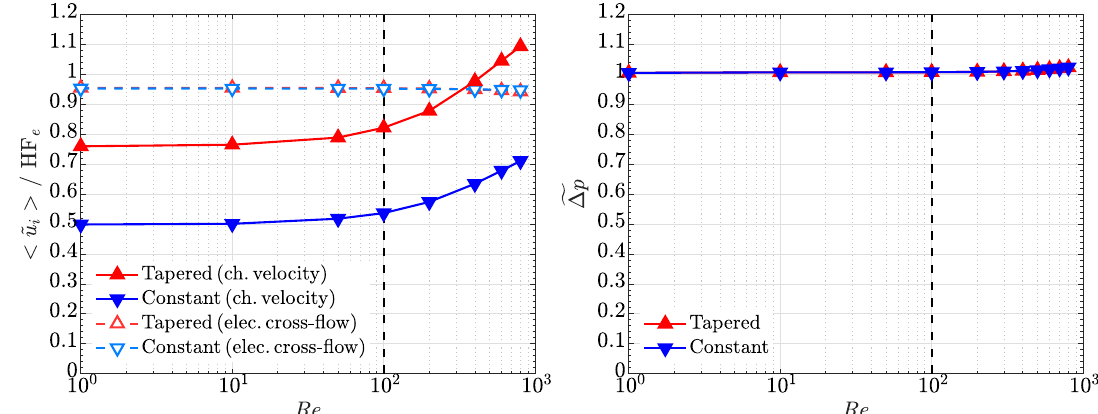
Figure 7. Variation of ( left ) the average axial velocity in the inlet channel, < ˜ u i > , and the homogeneity factor of the transverse velocity in the electrode, HF e , and ( right ) the overall pressure drop, (cid:102) ∆ p , as a function of the Reynolds number, Re , corresponding to the constant cross-section and tapered